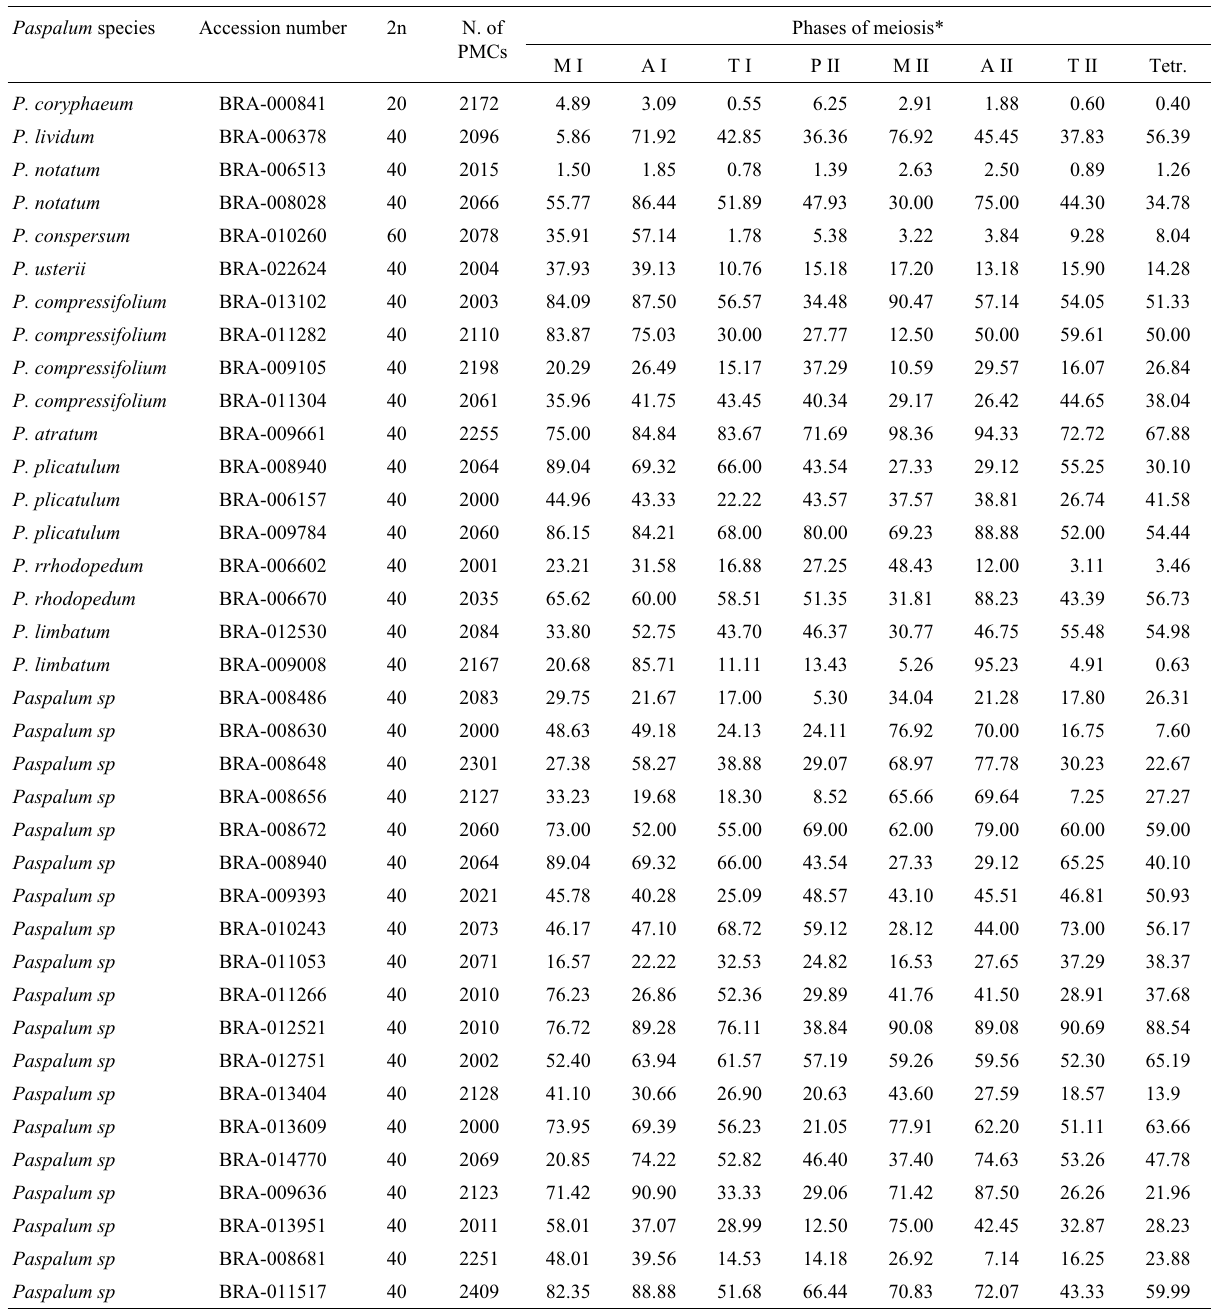
Table 3 - Number of microsporocytes analyzed and the percentage of cells with meiotic